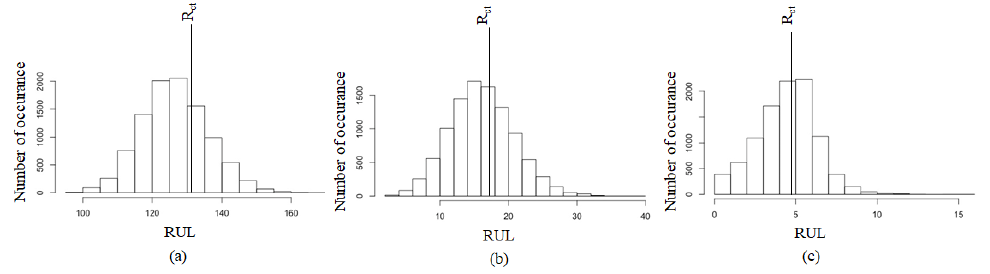
Figure 6. Position of the real crossing time R ct compared to histograms of RUL for simulated data with KNN algorithm at t = 0: ( a ) slow, ( b ) moderate, and ( c )